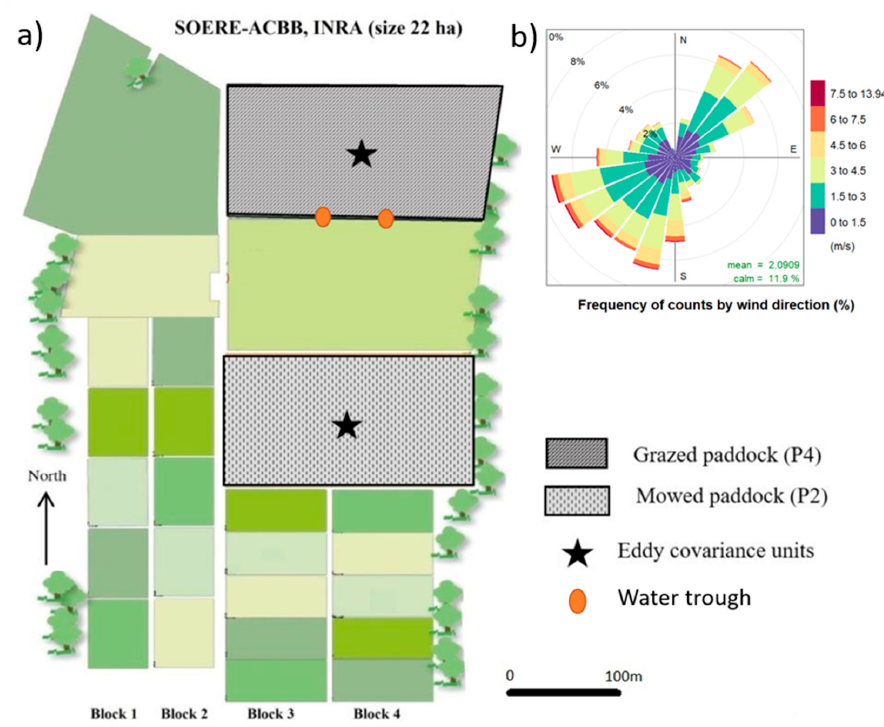
Figure 1. ( a ) Field site layout of the Agroecosystem Biogeochemical Cycles and Biodiversity (ACBB) experimental farm (22 ha). Di ff erent colors are used to distinguish di ff erent treatments. The treatments relevant for the present work are shown by stars indicating the location of the eddy covariance masts on the two studied paddocks (P2: mowed paddock; P4: grazed paddock). ( b ) The wind rose shows the frequency and intensity of winds blowing from di ff erent directions. The length of each “spoke” around the circle is related to the frequency of time that the wind blows from the specified